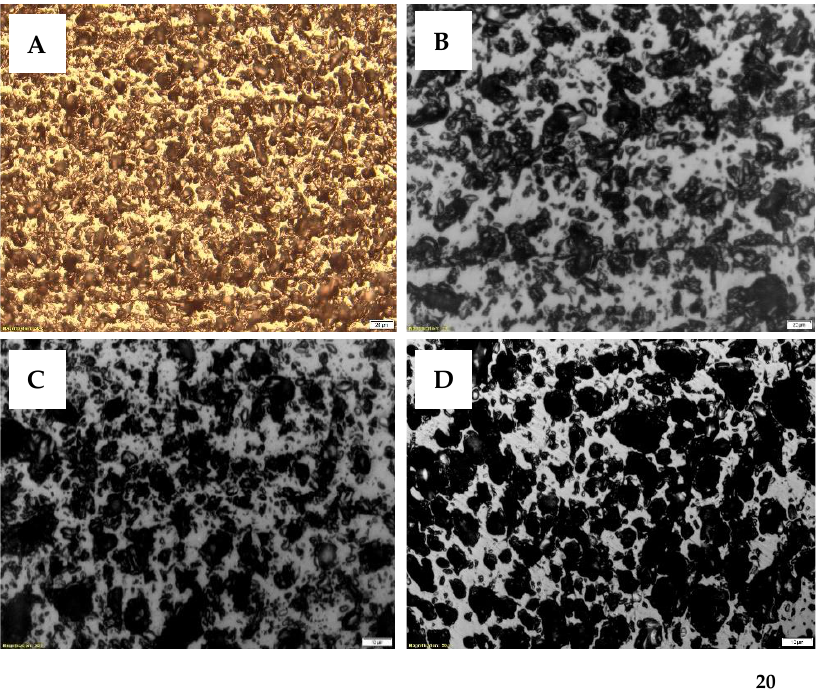
Figure 13. Textural and structural optical aspects typical for ACMP obtained from shells and kernels, correlated with S BET and iodine number, reflected light, glycerin immersion, 200X: ( A , B ) fine and very fine porosity predominantly below 10 µm in ACMP of walnut shells in sample A (iodine index 455 mg/g, S BET 295 m 2 /g) and sample B (iodine index 469 mg/g and S BET 251 m 2 /g); ( C ) microporosity of various sizes and thicker pore walls in ACMP of peach kernels (iodine index 488 mg/g and S BET 231 m 2 /g); ( D ) small porosity formed in ACMP of olive kernels (iodine index 397 mg/g and S BET 114 m 2 /g).